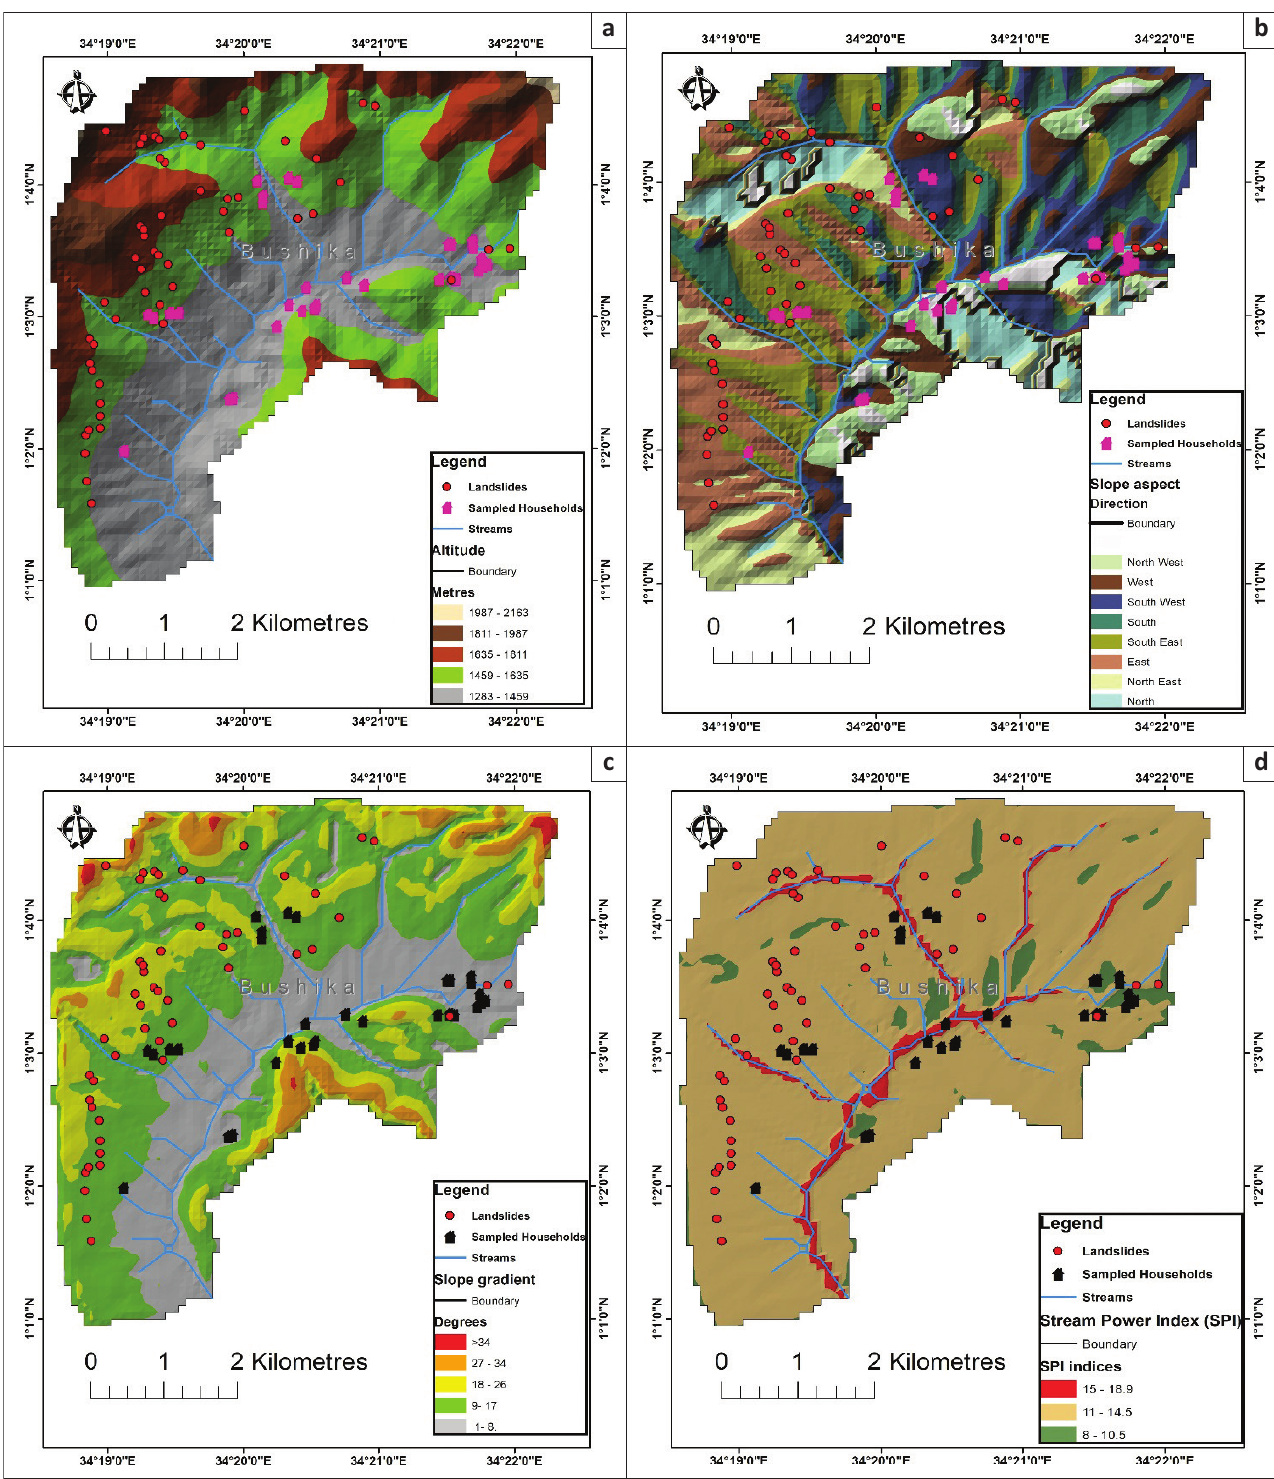
FIGURE 3: Landslide risk mapping for person with disability households using terrain factors of (a) Altitude; (b) Slope aspect; (c) Slope gradient; (d) Stream Power